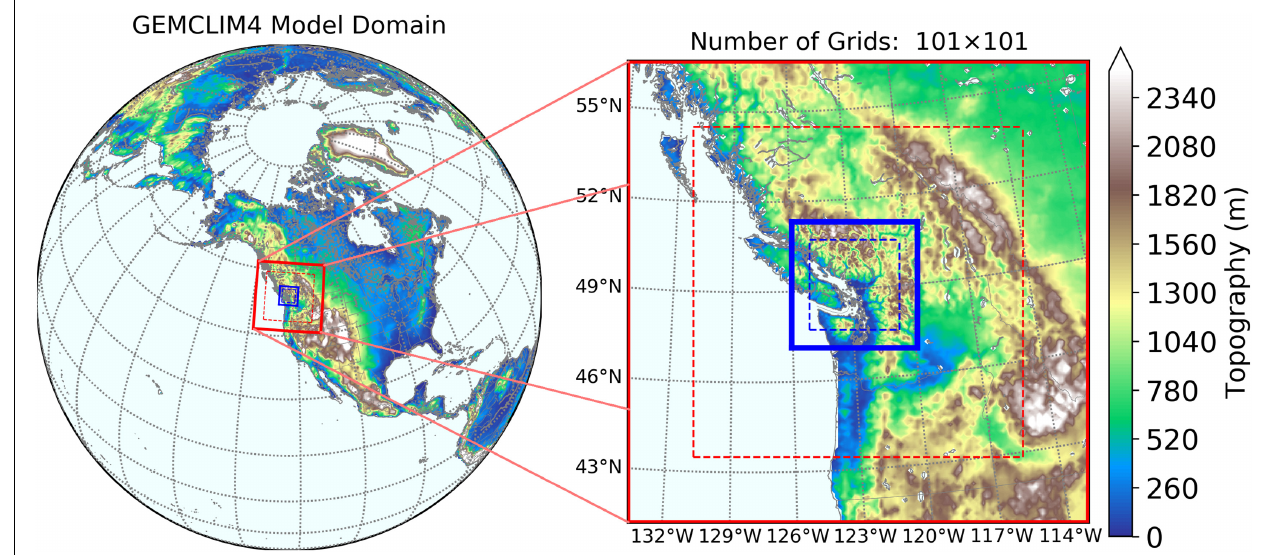
FIGURE 1 | Nested domains of the GEMCLIM model runs for Metro Vancouver at the 10-km (red) and 3-km (blue) resolutions. Areas between the solid and dash lines depict the lateral boundary zone of the model for boundary relaxation and semi-Lagrangian interpolation. Topography data is from the SRTM v3.0 dataset (Farr et al.,